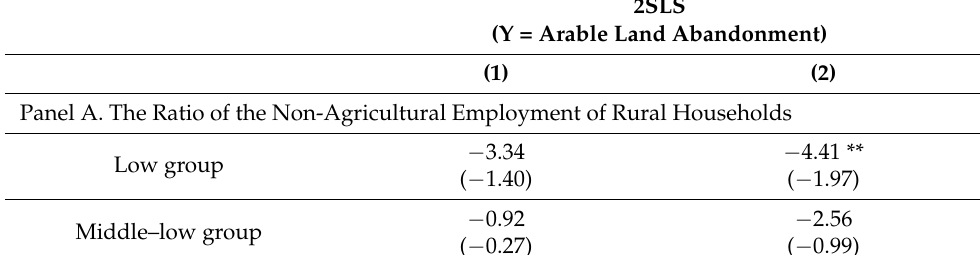
Table 8. The heterogeneity of labor resource endowment.